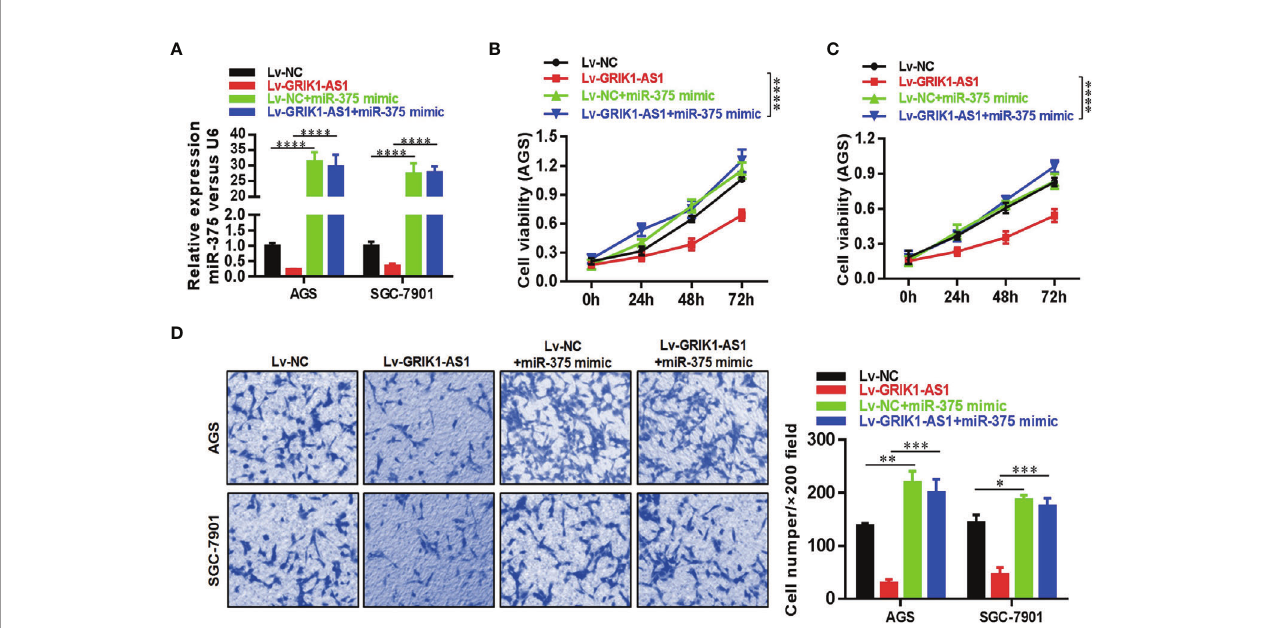
FIGURE 4 | miR-375 over-expression reverses the suppressed cell proliferation and invasion capability caused by GRIK1-AS1 over-expression. (A) Real-time qPCR analysis of miR-375 level in control and GRIK1-AS1 over-expressed AGS and SGC-7901 cells with or without miR-375 over-expression. (B, C) Cell proliferation assays of control and GRIK1-AS1 over-expressed AGS and SGC-7901 cells with or without miR-375 over-expression. (D) Trans-well assays of control and GRIK1- AS1 over-expressed AGS and SGC-7901 cells with or without miR-375 over-expression. * P < 0.05, ** P < 0.01, *** P < 0.005, **** P < 0.0001.